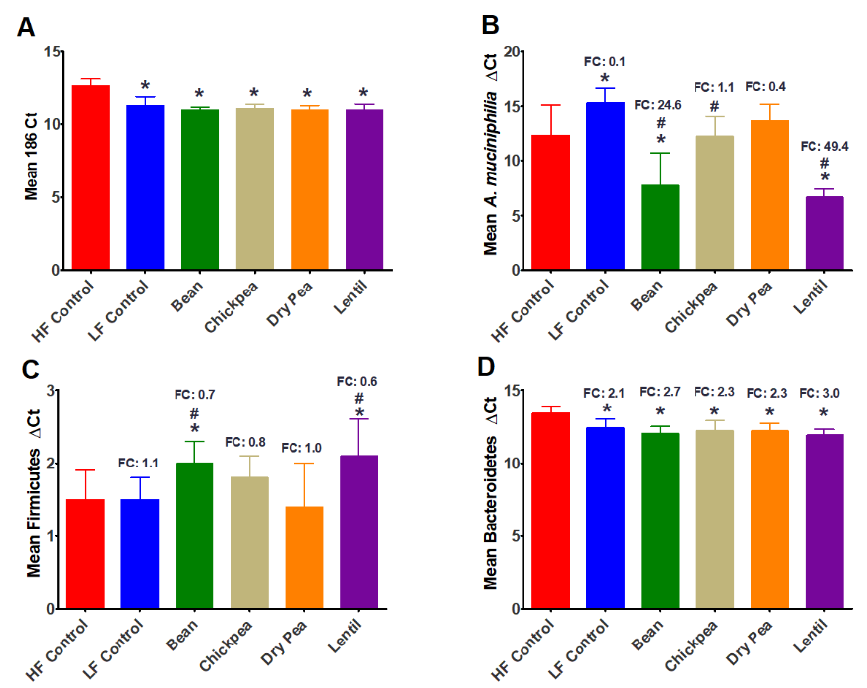
Figure 2. Effect of feeding pulse diets on cecal bacteria populations. ( A ) 16S Ct for 20 ng genomic DNA, mean ± SEM; ANOVA:LF Control p < 0.0001, Bean p < 0.0001, Chickpea p < 0.0001, Dry Pea p <